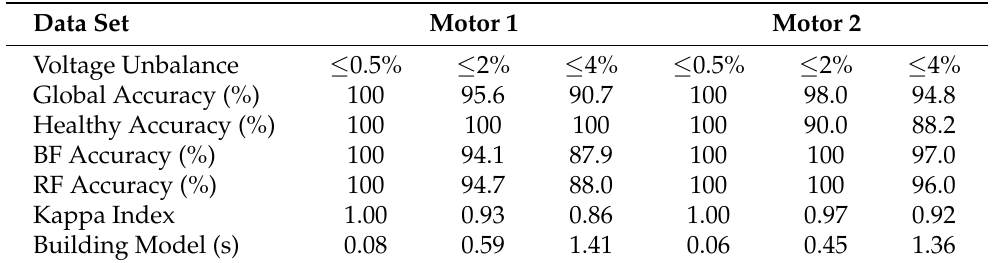
Table 9. Experimental results using PCA for reduce the SMI attributes—Multi-fault identification.